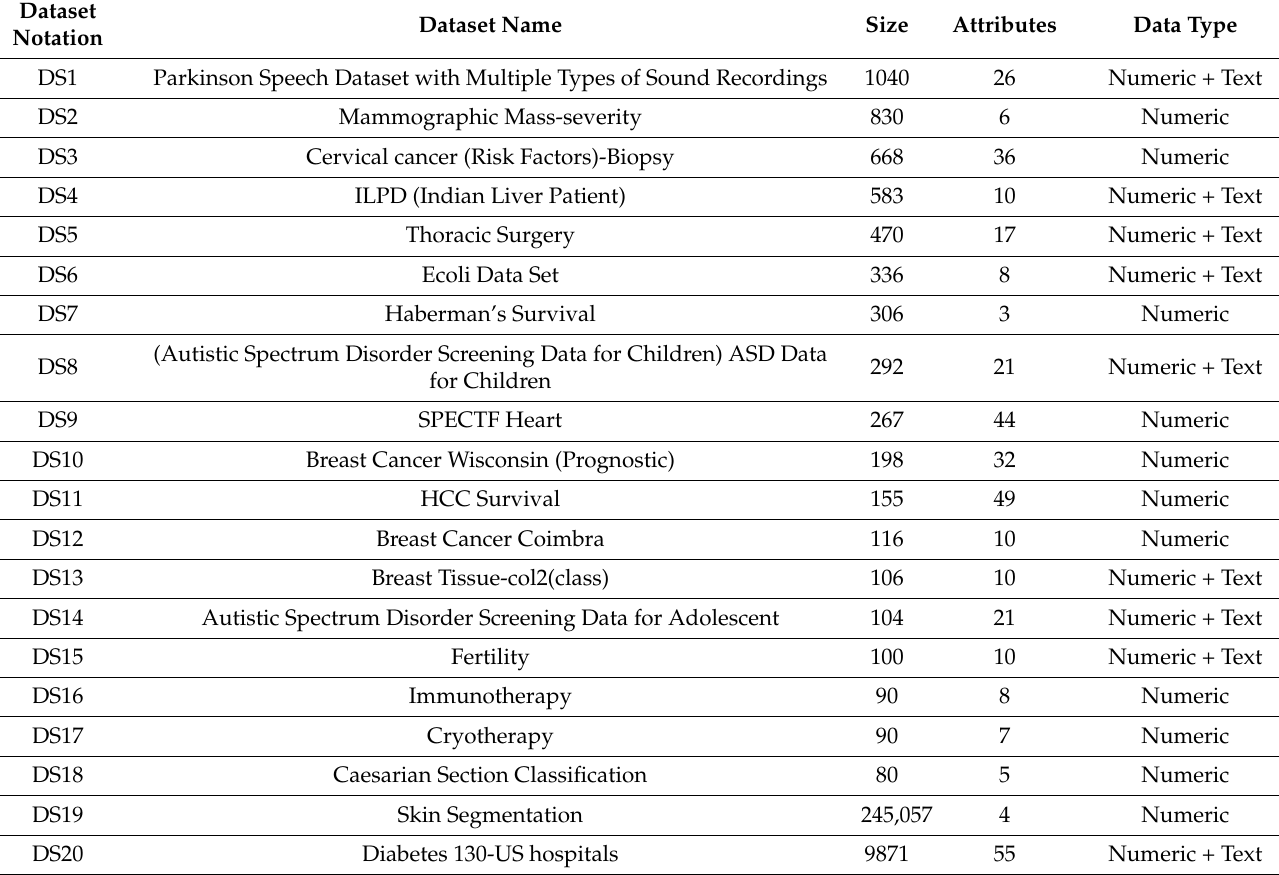
Table 2. Datasets description.